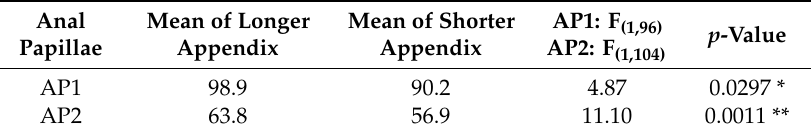
Table 2. Result of ANOVA to detect asymmetry of anal papillae of D. melanogaster larvae, * p < 0.05, ** p < 0.01.